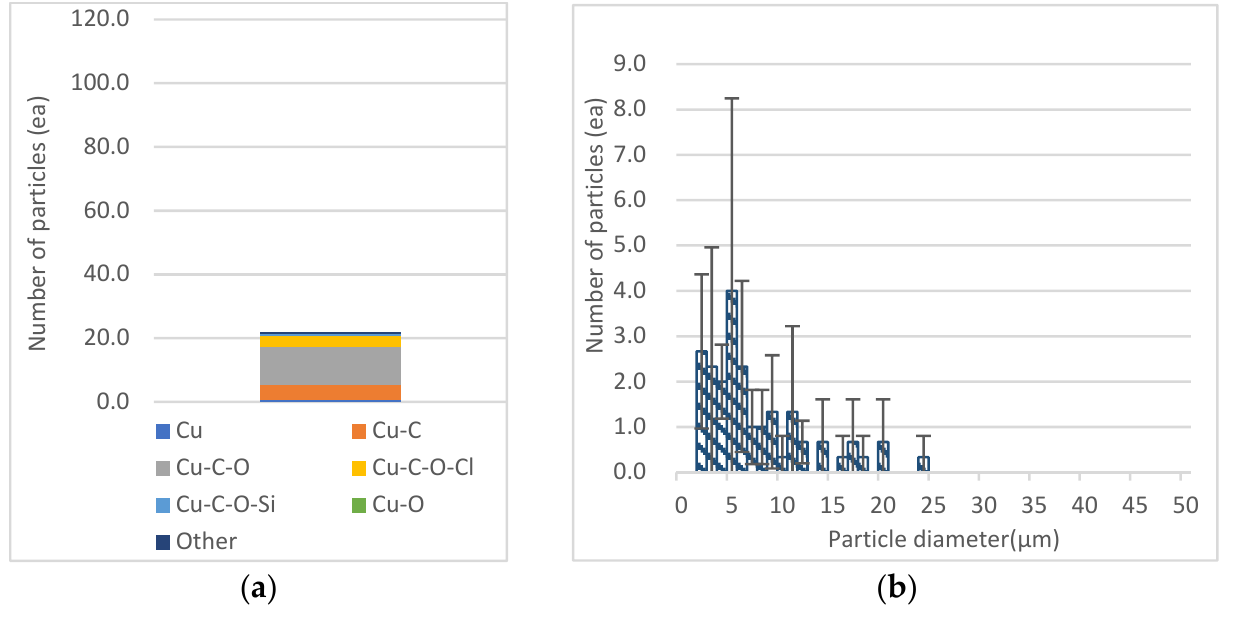
Figure 6. Composition of chemical categories and number of total Cu particles: ( a ) Composition of chemical categories; ( b ) number of total Cu particles by aerodynamic diameter ( μ m).